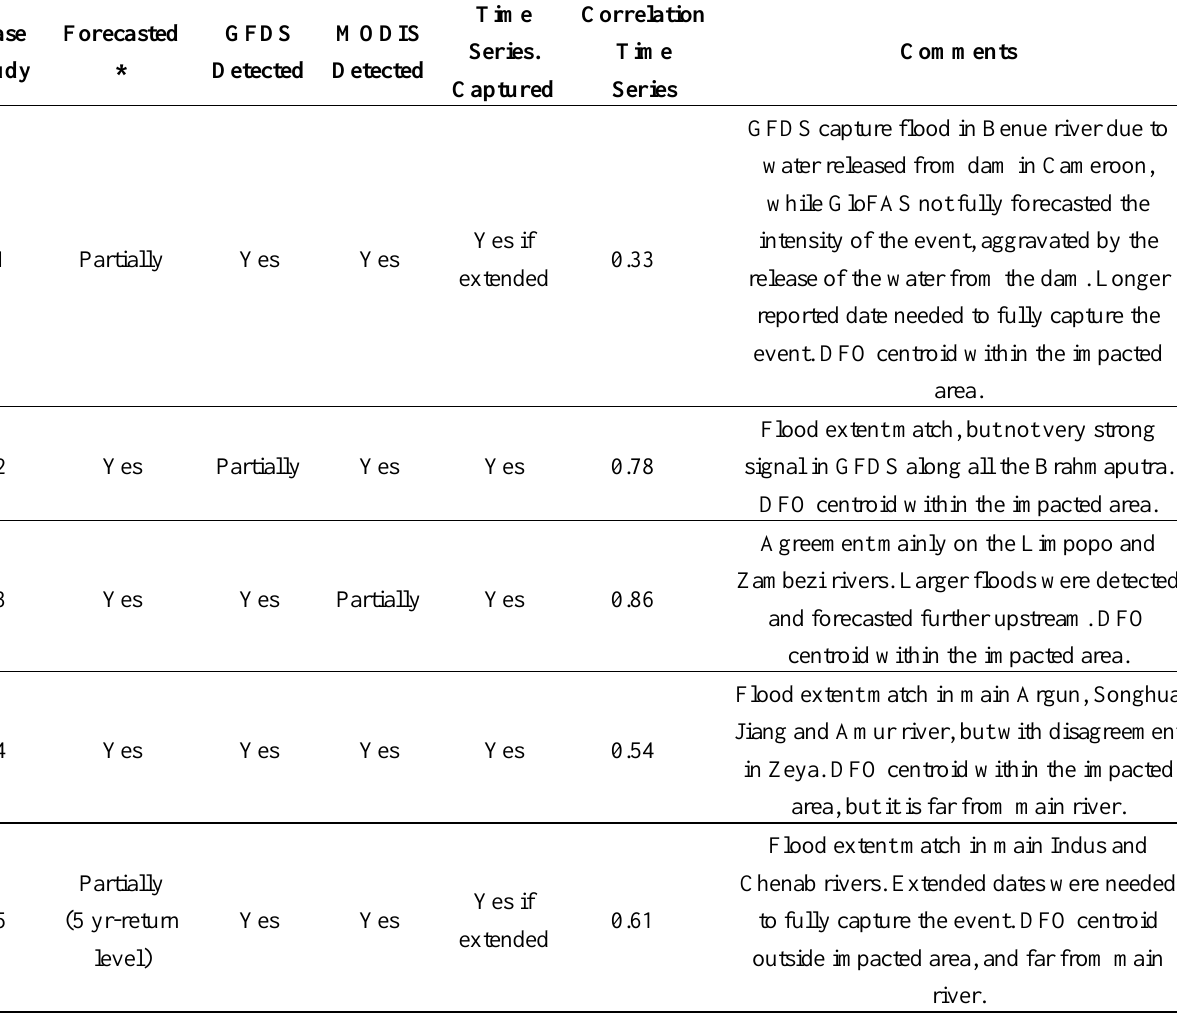
Table 2. Summary of the results from analysis of the GFDS and MODIS flood detection, and GloFAS forecast for the 10 case studies. * Based on five-day lead GloFAS exceedance of the 20-year return level (for Case 5, a five-year return level is